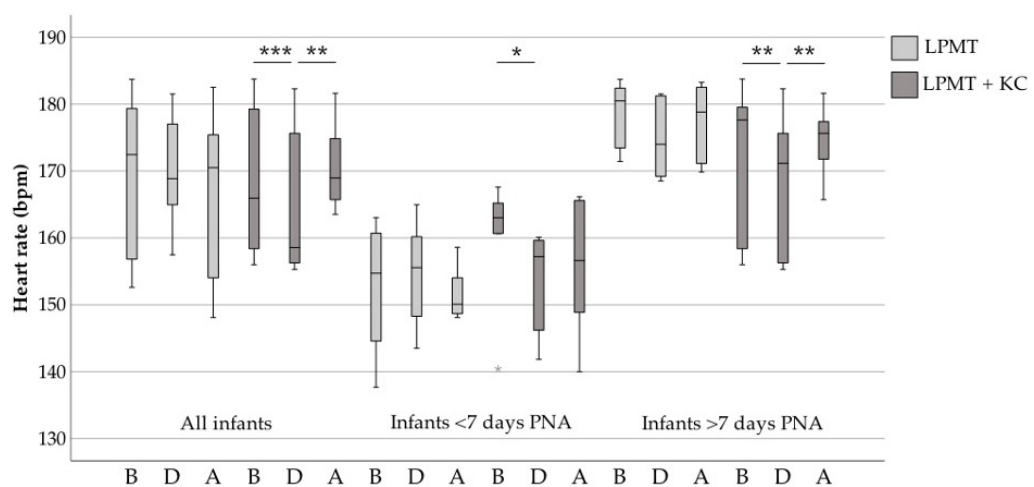
Figure 1. Heart rate before, during and after LPMT compared with combined interventions. The boxes represent the interquartile ranges and the whiskers represent the range of all infants. Grey stars indicate the outliers of this study. PNA, Postnatal age; LPMT, live-performed music therapy; KC, kangaroo care; Bpm, beats per minute; B, before therapy; D, during therapy; A, after therapy; *, p < 0.05; **, p ≤ 0.01; ***, p ≤ 0.001.